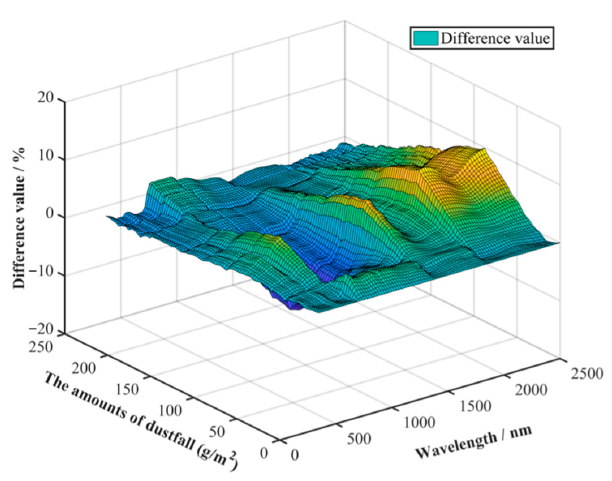
Figure 12. Error surface obtained based on the dust accumulation mode shown in Figure 11.